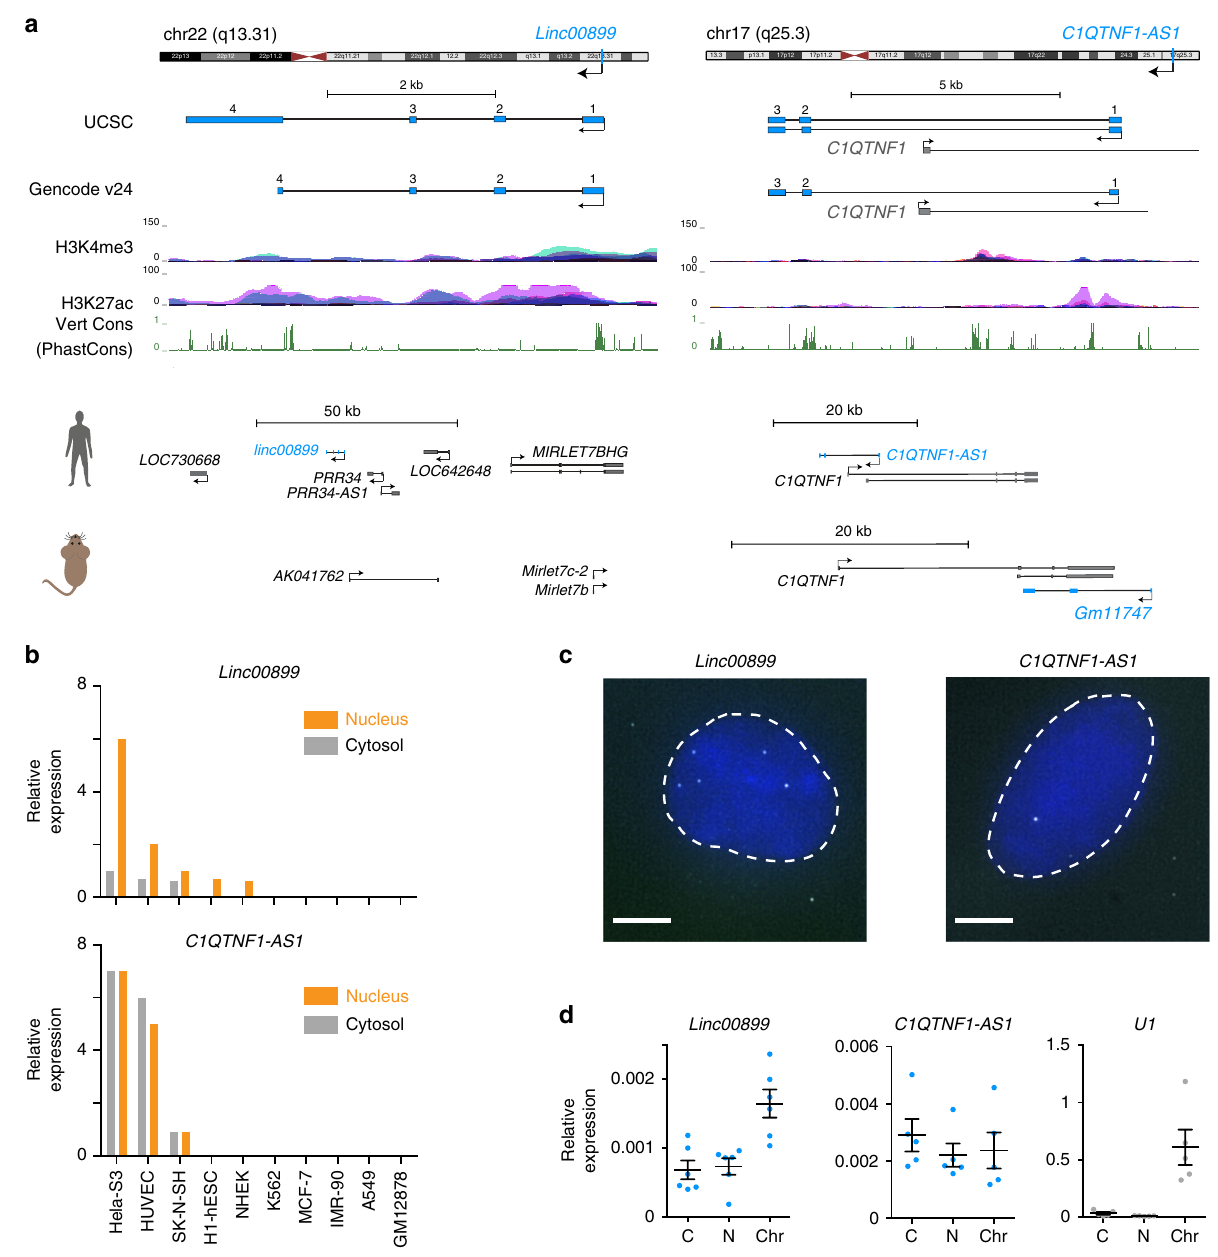
Fig. 2 Molecular characterisation of the linc00899 and C1QTNF1-AS1 lncRNAs. a Schematic representation of the genomic landscape surrounding linc00899 (annotated in RefSeq as NR_027036; Gencode gene ENSG00000231711 ; chr22:46039907-46044868, hg38) and C1QTNF1-AS1 (annotated in RefSeq as NR_040018/NR_040019; Gencode gene ENSG00000265096 ; chr17:79019209-79027601, hg38). Marks of active transcription in HeLa cells (H3K4me3 and H3K27ac, obtained from ENCODE via the UCSC browser) and conservation scores by PhastCons are also shown. Putative conserved mouse lncRNAs based on syntenic conservation are shown below. b Expression of linc00899 and C1QTNF1-AS1 in the nucleus (orange) and cytosol (grey) of ENCODE cell lines, shown as reads per kilobase of exon per million reads mapped. c Single-molecule RNA FISH using exonic probes (white) against linc00899 and C1QTNF1-AS1 . Nuclei were stained with DAPI (blue). Scale bar, 5 µ m. d qPCR quanti fi cation of lncRNA levels in RNA fractions extracted from different cellular compartments (C cytoplasm, N nucleoplasm, Chr chromatin). U1 small nuclear RNA was used as a positive control for the chromatin fraction. Error bars represent the standard error of the mean±S.E.M from at least fi ve independent experiments. Source data are provided as a Source Data fi